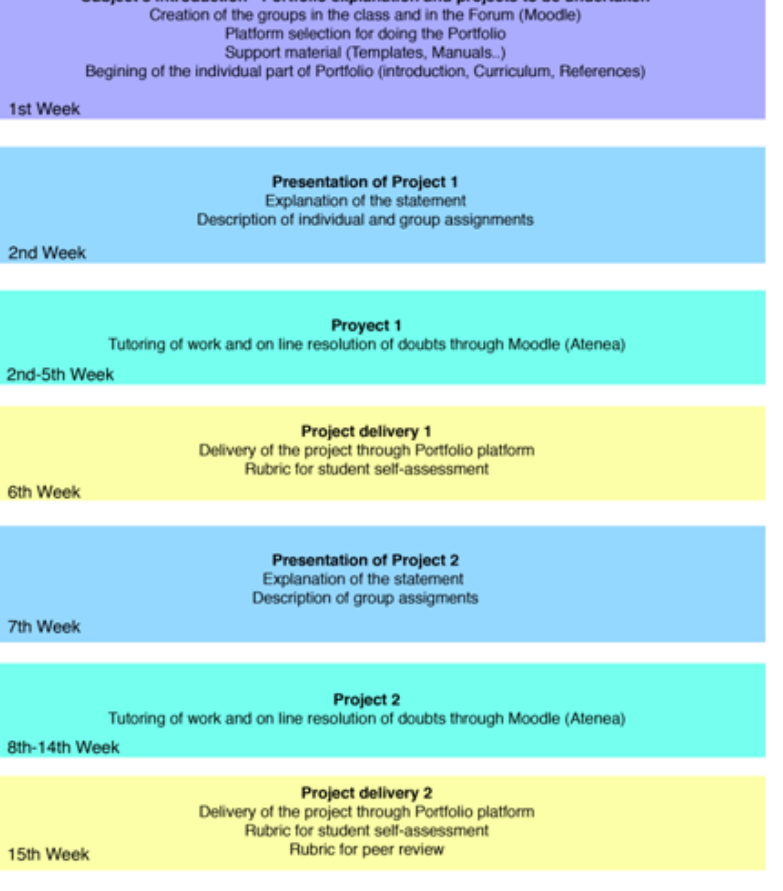
Figure 2. Subject